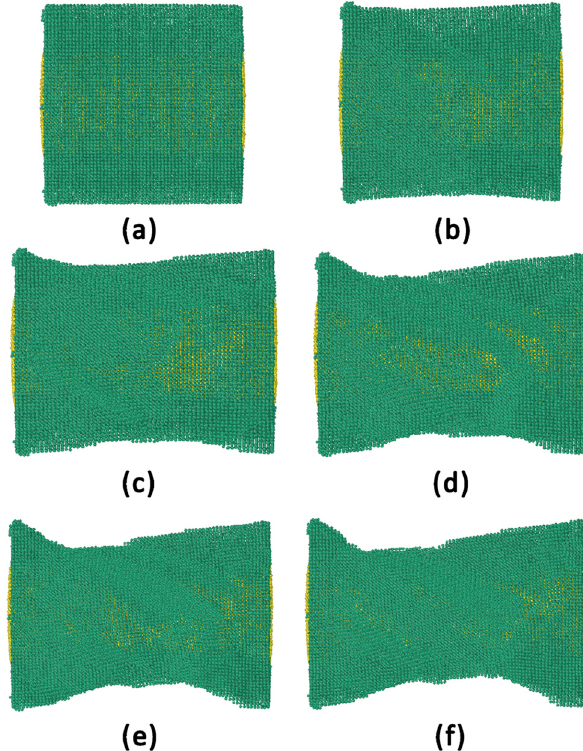
Figure 4: Illustration of uniaxial tension steps of Ni – Al core – shell nanowire at di ff erent strains: ( a ) ε = 0, ( b ) ε = 0.02, ( c ) ε = 0.05,